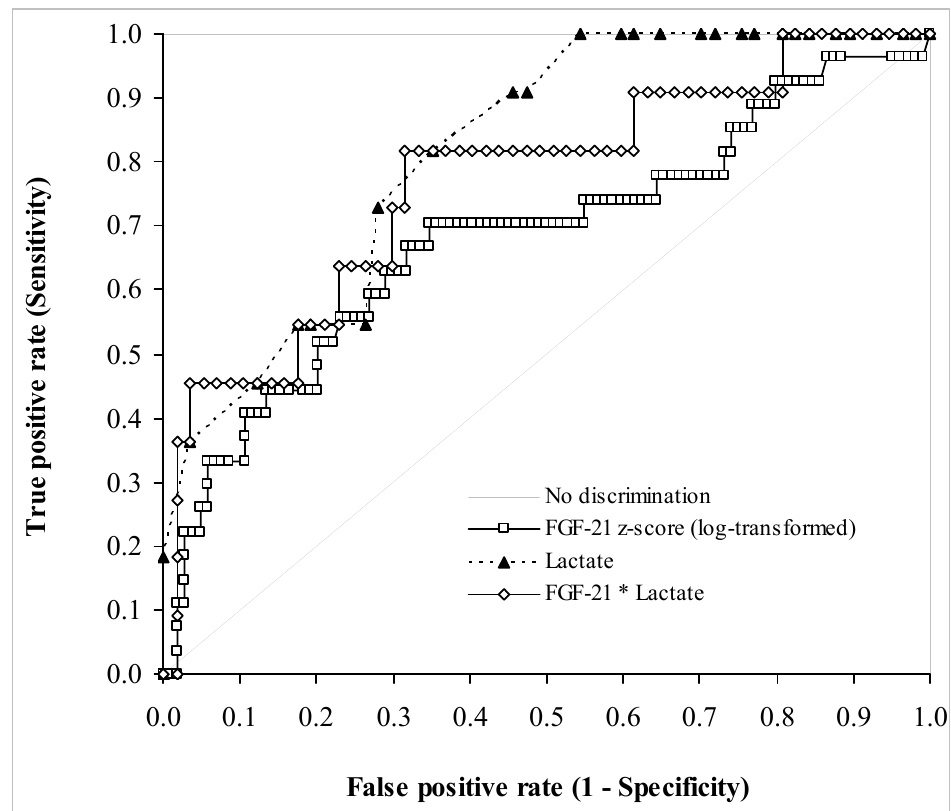
Figure 2. Distribution of FGF ‐ 21 z ‐ scores in patients investigated for mitochondrial disease (MD). Patients were grouped according to the final diagnoses, with those who were likely to have MD but whose further investigations were still pending placed in the possible MD group.